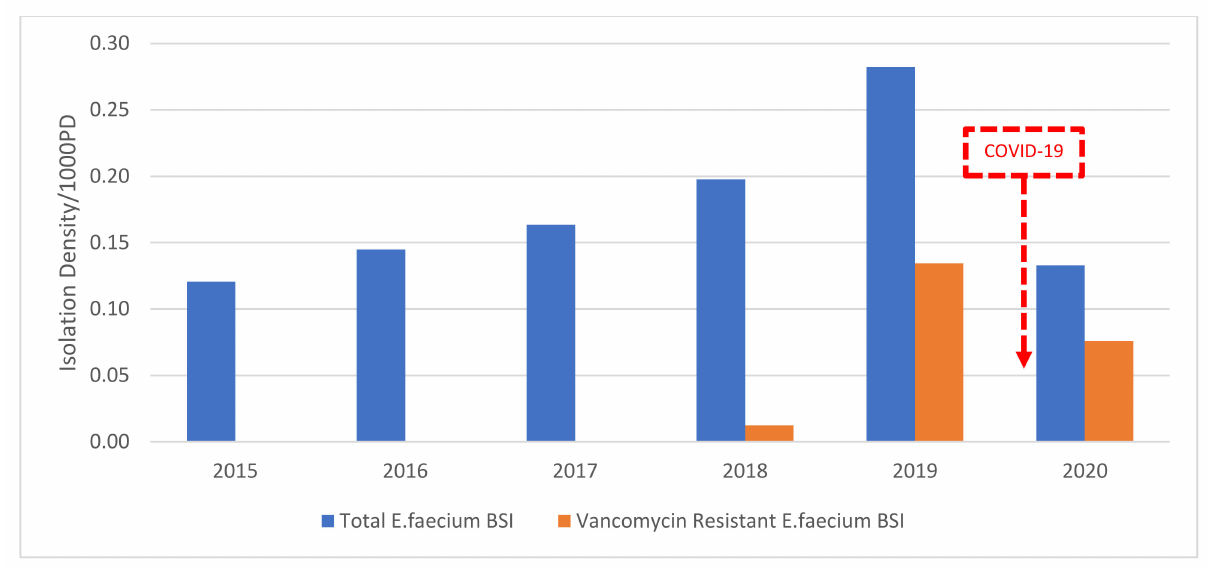
Figure 4. The isolation density per 1000 PD of total E. faecium and Vancomycin-resistant E. faecium bloodstream isolates from 2015–2020 at SGHUMC.